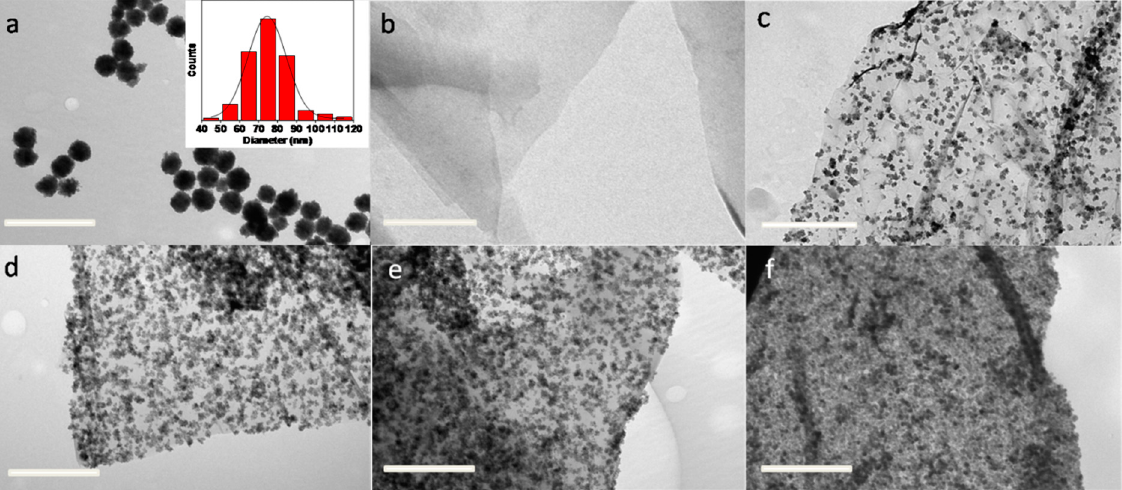
Figure 1. The TEM micrographs of the ( a ) clusters of Fe 3 O 4 /Fe 2 O 3 nanoparticles, particle size distributions (inset), and ( b ) rGO sheets. Panels ( c – f ) corresponded to the TEM images of the Fe 3 O 4 /rGO hybrids as MR30, MR20, MR10, and MR5, respectively (scale bar: 500 nm).